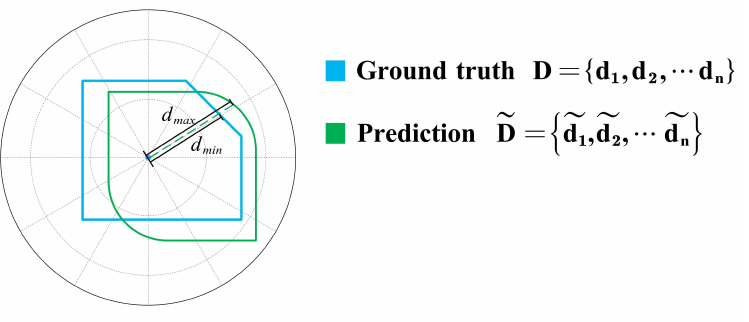
Figure 9. Schematic diagram of CS